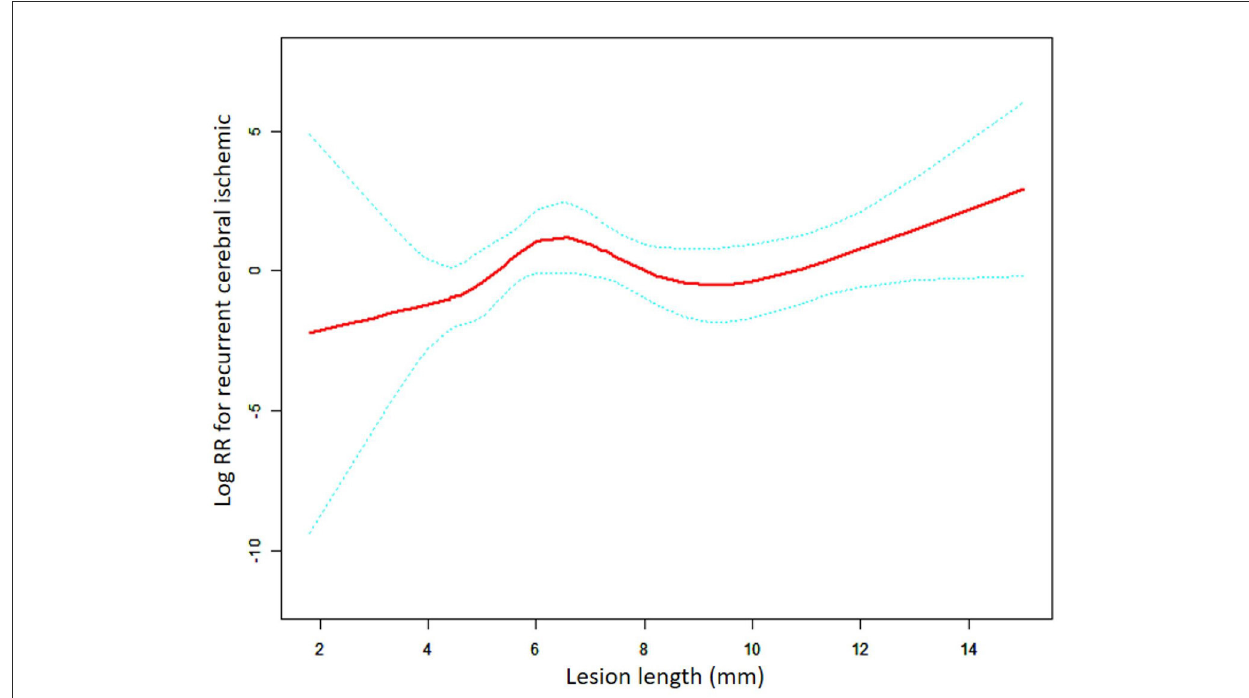
FIGURE2 A non-linear association between lesion length and recurrent cerebral ischemic in the BES group. The red solid line indicates the smooth curve fit between lesion length and RCI. The blue dotted line represents the 95% confidence interval of the fit (RR, relative risk).